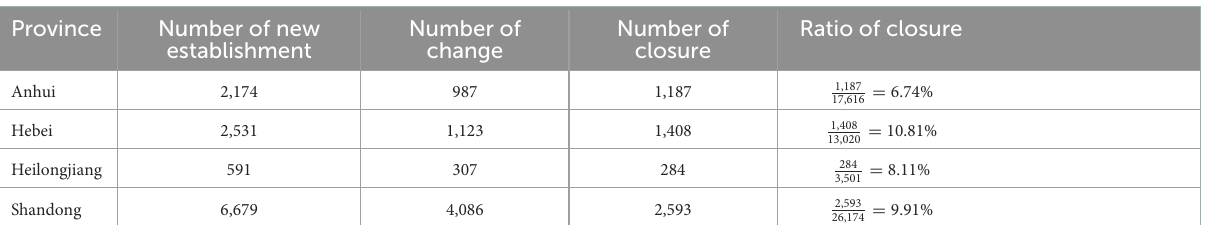
TABLE 2 Ratio of IEDS that closed in 2020. Province Number of new establishment